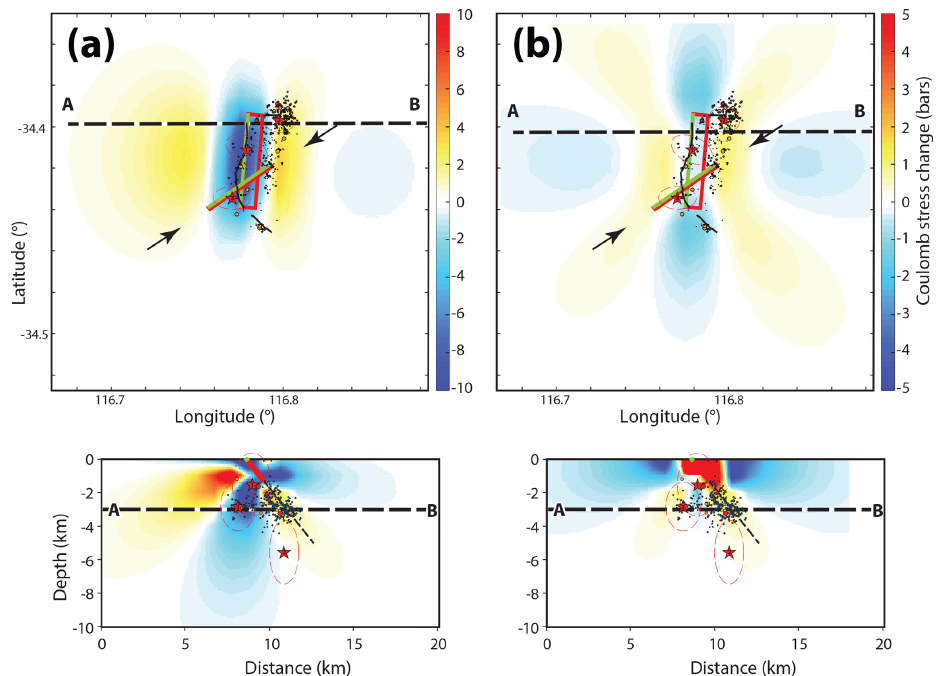
Figure 8. Coulomb stress changes resulting from the September M w 5.3 event (upper panels show a horizontal section at 3km depth, and lower panels show a vertical section along the line A–B), (a) resolved for reverse faults parallel to the November rupture plane and (b) resolved for optimally oriented strike-slip faults. The rupture area was modelled as being 5.0km long by 1.17km wide to constrain seismic moment and slip and 50 ◦ east-dipping, consistent with the USGS focal mechanism for the event (Fig. 2, Table 2). Relocated hypocentres prior to the November mainshock are projected onto the horizontal plane in the upper panels, and onto the vertical A–B section plane in the lower panels (see Fig. 3 for seismicity legend). Black line is the surface deformation trace interpreted from ground observations and InSAR data. Black arrows in the upper panels point to the position of the November M w 5.3 strike-slip event rupture